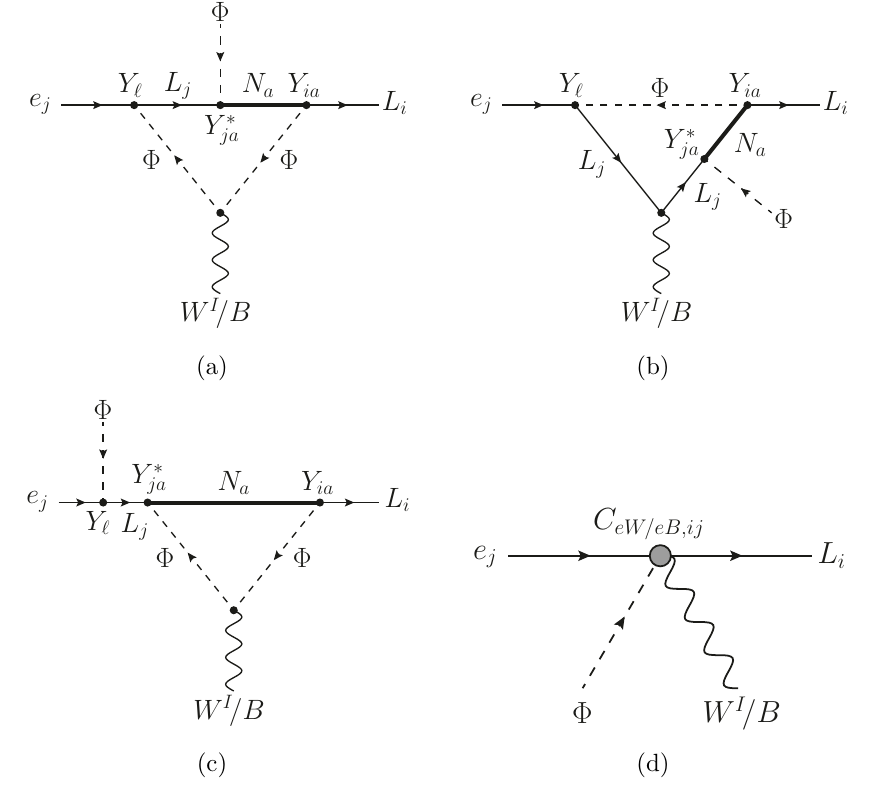
Figure 6. (a-c) Diagrams contributing to the matching onto the magnetic operators O eW and O eB . (d) Diagram in the effective theory resulting from the magnetic